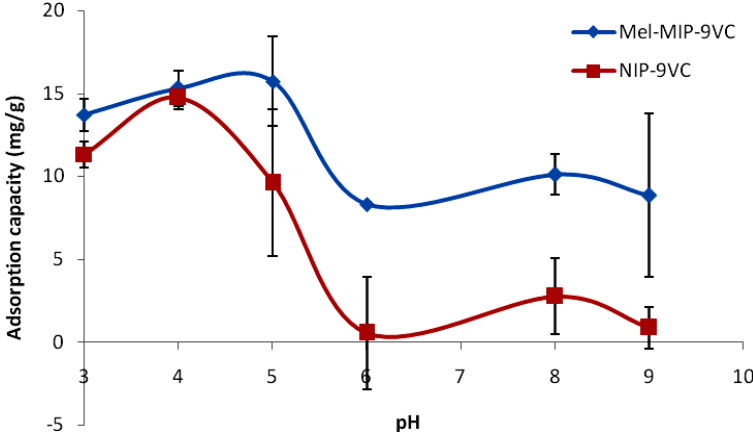
Figure 5. Effect of pH on adsorption of melamine by Mel-MIP-9VC and NIP-9VC particles. Experiment was conducted by using 10.0 mg of molecularly imprinted polymer (MIP) with 10.0 ppm of melamine